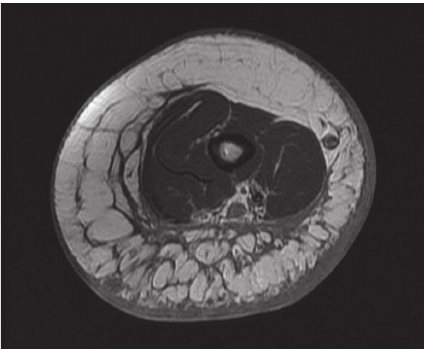
Figure 4: MRI of the soft parts of the upper left limb objectivating edematousinfiltrationofthefattytissuewiththepresenceofnodular formation opposite the brachial